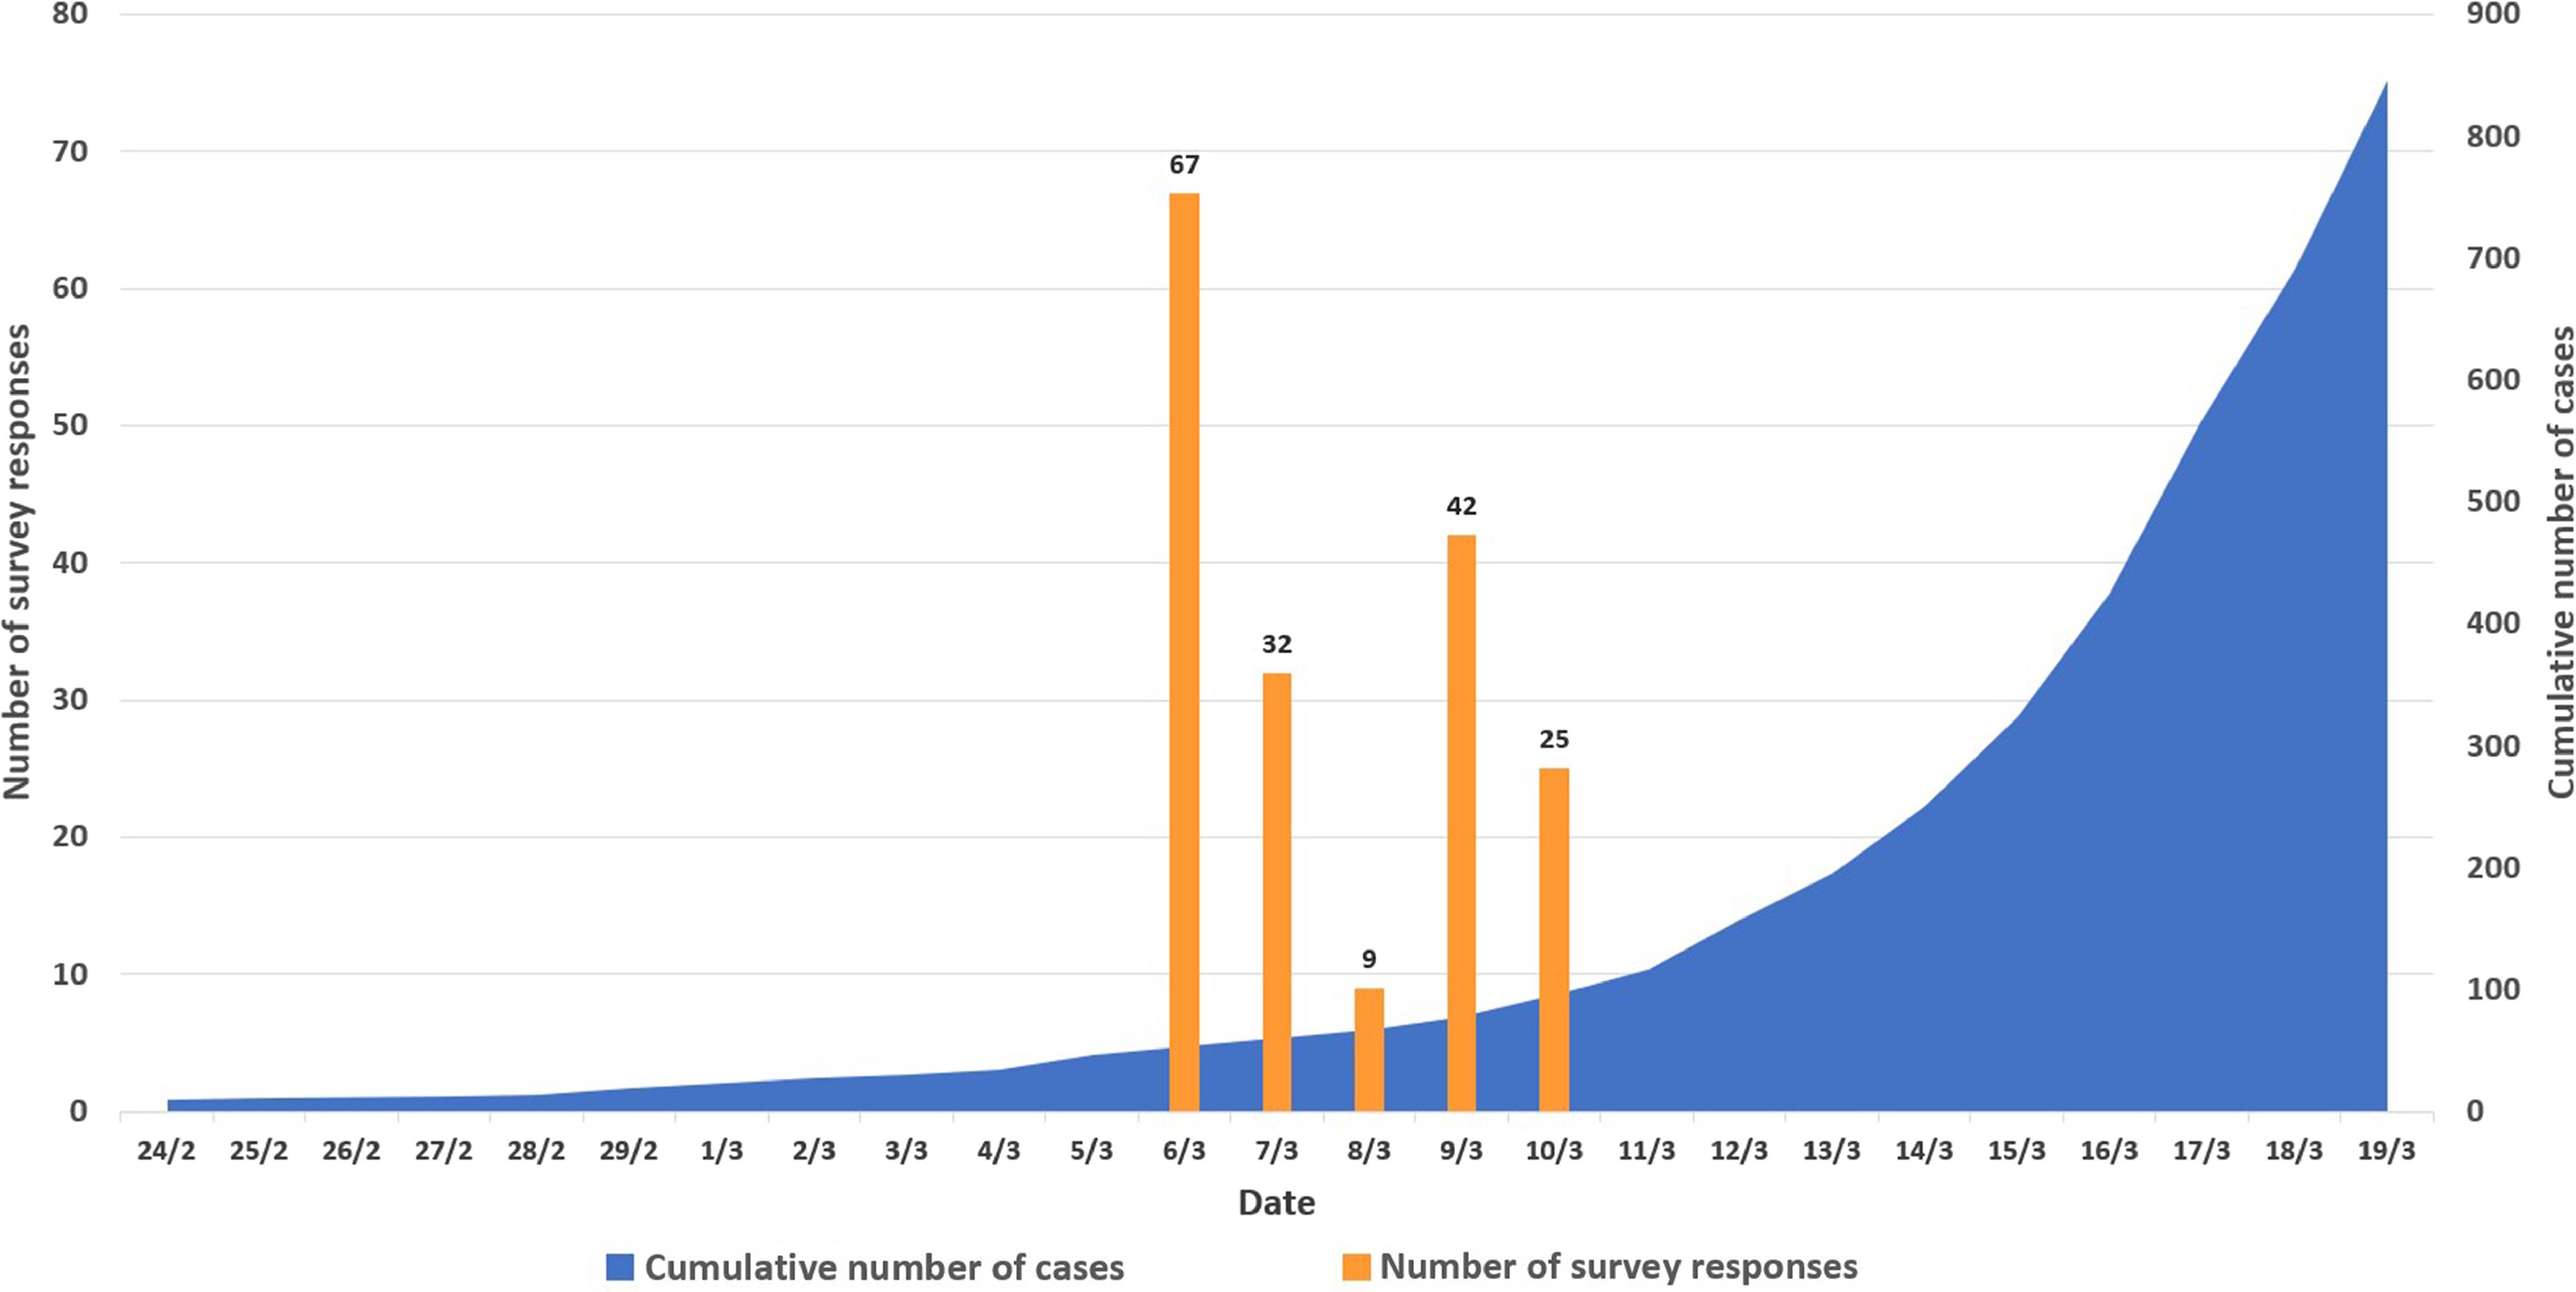
Timing of study in relation to the COVID-19 outbreak in Canada.